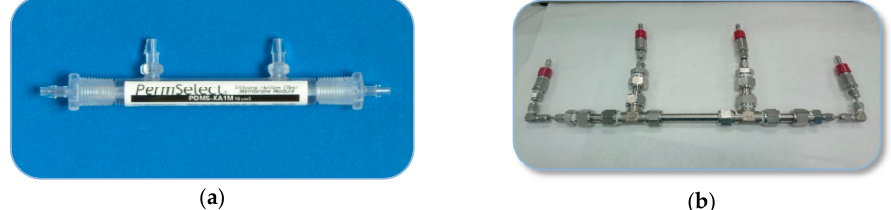
Figure 2. Photographs of the commercial PDMSXA ‐ 10 HF membrane module and the home ‐ made stainless ‐ steel modules used to measure the separation performance of the CHF and MMCHF membranes in our laboratory. Table 1. Sequence of CO 2 separation experiments conducted for each membrane. Experiment 1 CO 2